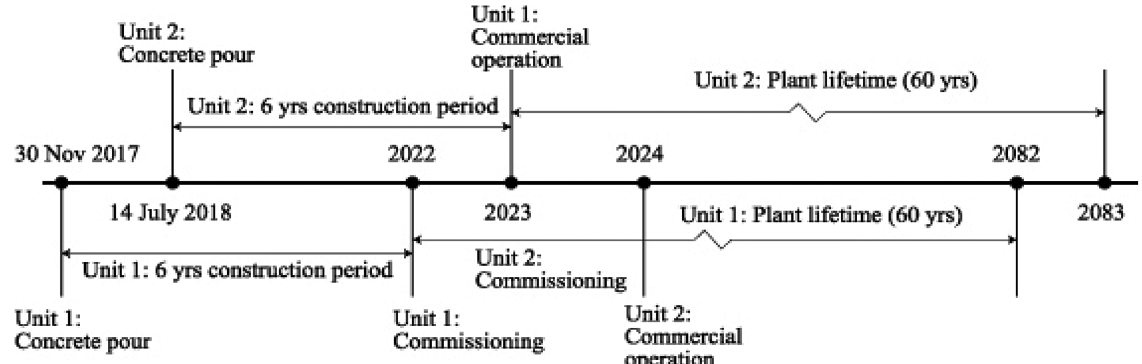
Figure 2. Construction, commissioning, and commercial operation schedule of the twin VVER-1200MWe model reactors at